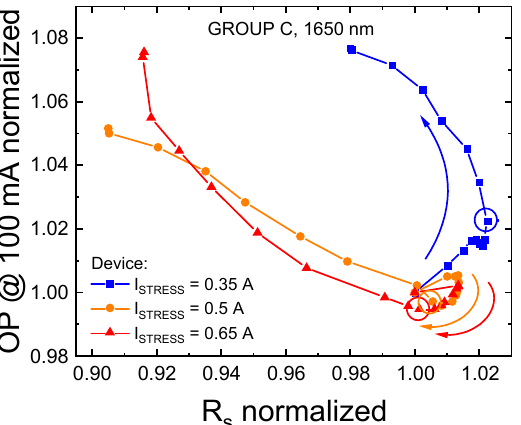
Figure 8. Correlation between the normalized series resistance and the OP measured at 100 mA (nominal current) and T AMB = 25 °C after each stress cycle during the constant-current aging experiments carried out on group C samples, at the stress temperature of T STRESS = 45 °C.